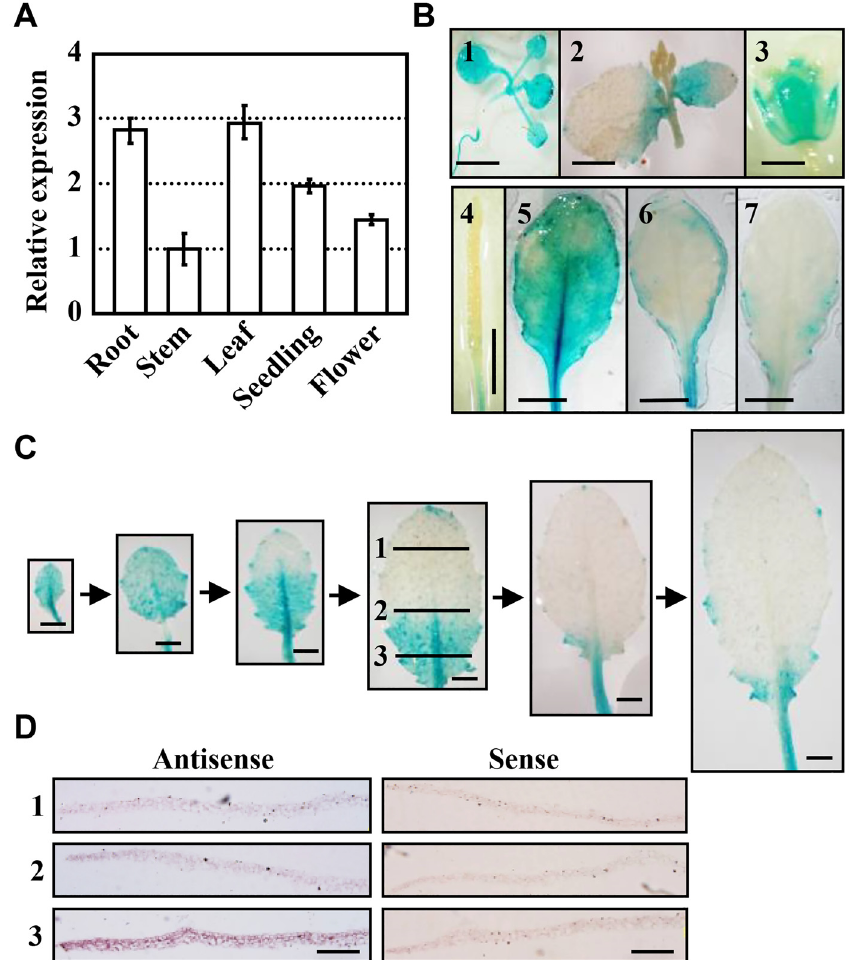
Fig 1. PI4K γ 5 is expressed in various tissues and exhibits a dynamic expression pattern along with leaf development. A. qPCR analysis revealed the expression of PI4K γ 5 in various tissues. ACTIN7 gene was used as an internal reference and transcription level of PI4K γ 5 in stem was set as 1.0. The experiments were repeated three times and data are presented as means ± SE (n = 3). B. Promoter-GUS fusion analysis showed the PI4K γ 5 expression in young seedling (1), cauline leaf (2), floral tissue (3), fruit (4), and 5 th – 7 th rosette leaves (5 – 7). Bars = 5 mm. C. Dynamic expression of PI4K γ 5 along with the 7 th rosette leaf development. Representative images were shown. Bars = 2 mm. D . In situ hybridization analysis of PI4K γ 5 mRNA in 7 th rosette leaf. Different regions including distal (1), central (2) and proximal (3) of leaf (highlighted in C) were sectioned. Bars = 0.5